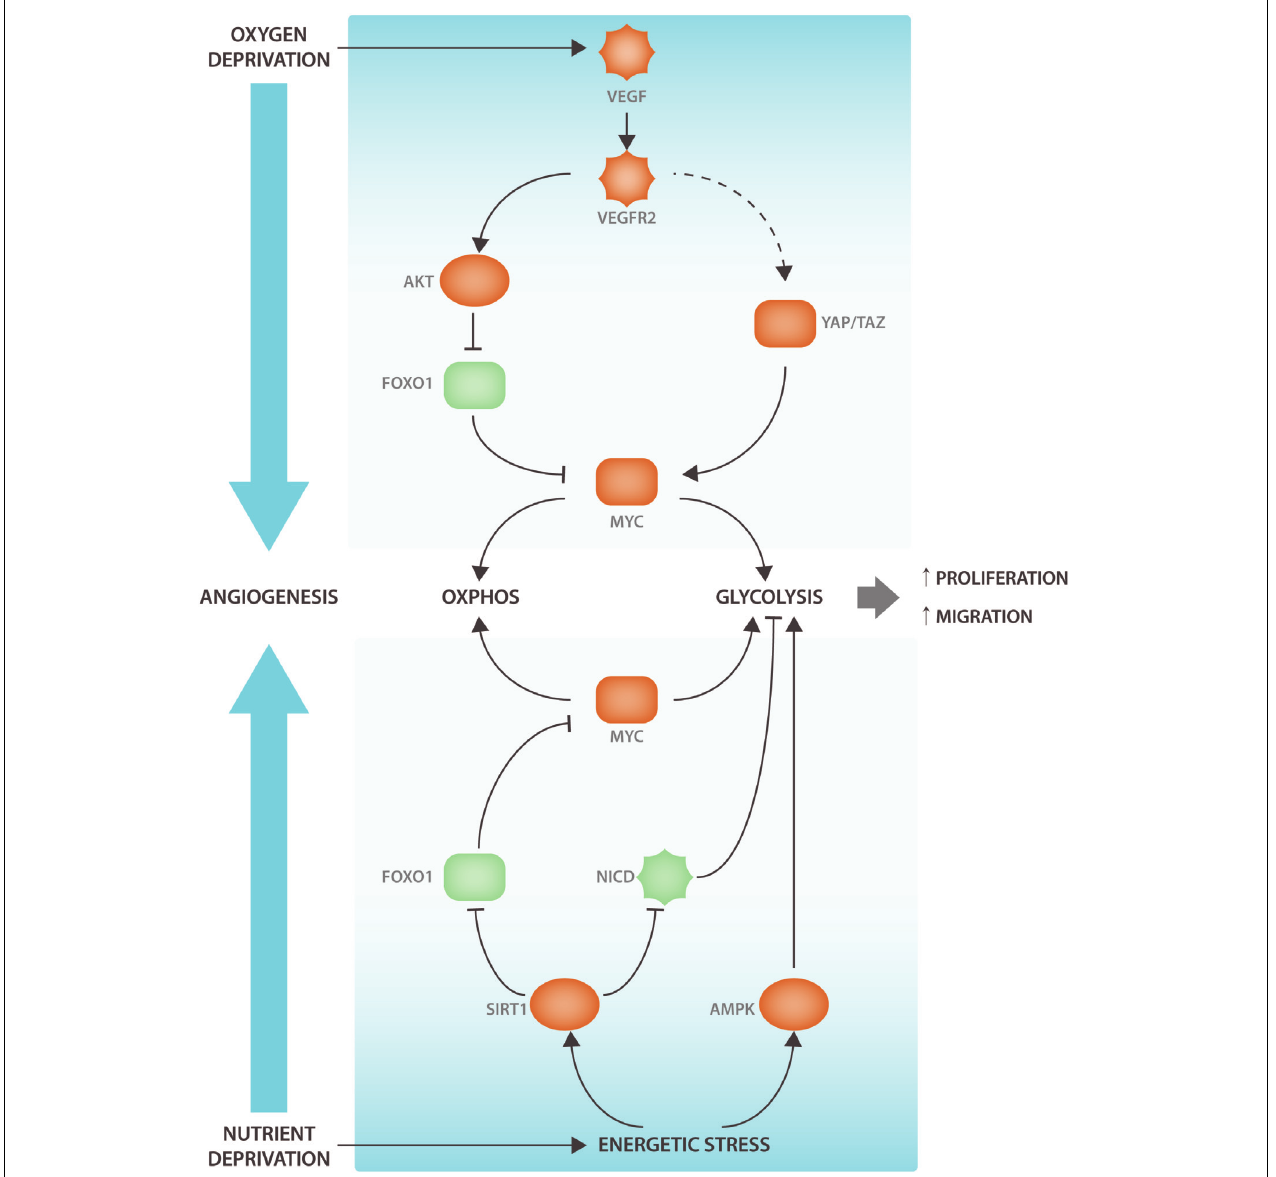
FIGURE 1 | Angiogenic signaling cascades interact with metabolic regulators. VEGF signaling interacts with the ECs’ nutrient sensing apparatus to induce metabolic changes and promote angiogenesis. When oxygen levels decrease, the surrounding tissue will secrete VEGF that will bind to its receptor VEGFR2 present on the ECs. VEGF-induced AKT activation will lead to FOXO1 phosphorylation. When FOXO1 is phosphorylated, it will be excluded from the nucleus and therefore be unable to inhibit MYC transcriptional activity. Moreover, VEGF also leads (via cytoskeletal rearrangements) to YAP/TAZ activation, two transcription factors that have been shown to be involved in metabolic reprogramming via the transcription factor MYC. AMPK and SIRT1 are nutrient sensors that become activated under energetic stress conditions. SIRT1 modulates NICD and FOXO1 activity through deacetylation. AMPK activation enhances EC migration and proliferation by increasing glycolysis. Pro-angiogenic factors are indicated in red and anti-angiogenic factors are indicated in